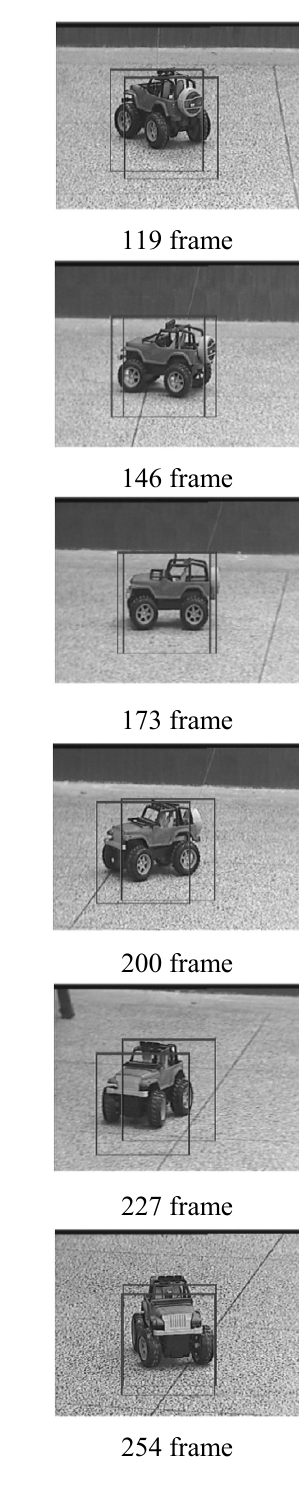
Figure 11. Tracking with proposed method in case of poses